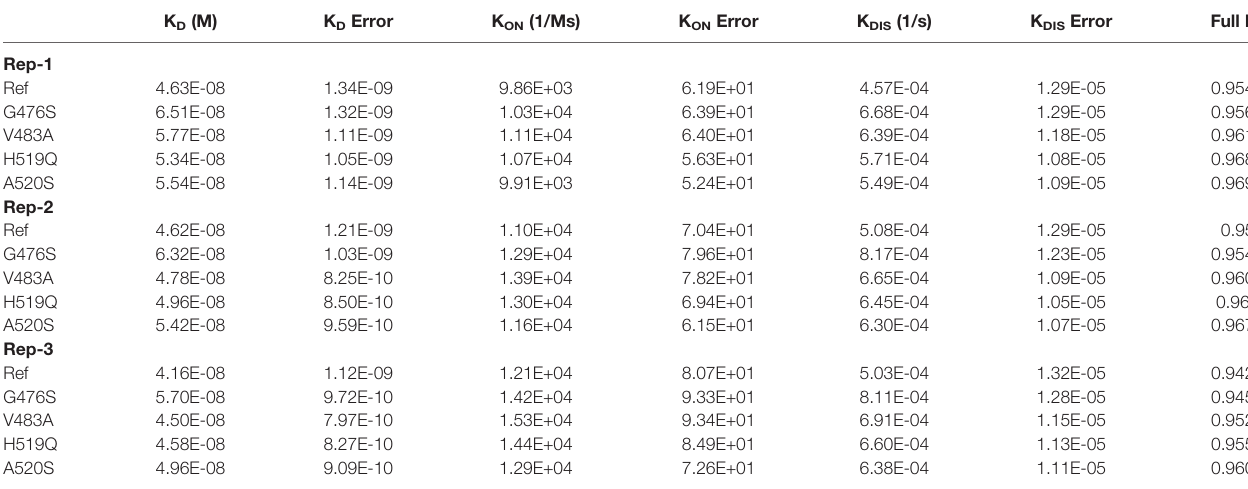
TABLE 4 | Kinetics pro fi les of S-RBD reference/mutants and hACE2-ECD. K D (M) K D Error K ON (1/Ms) K ON Error K DIS (1/s) K DIS Error Full R 2 Rep-1